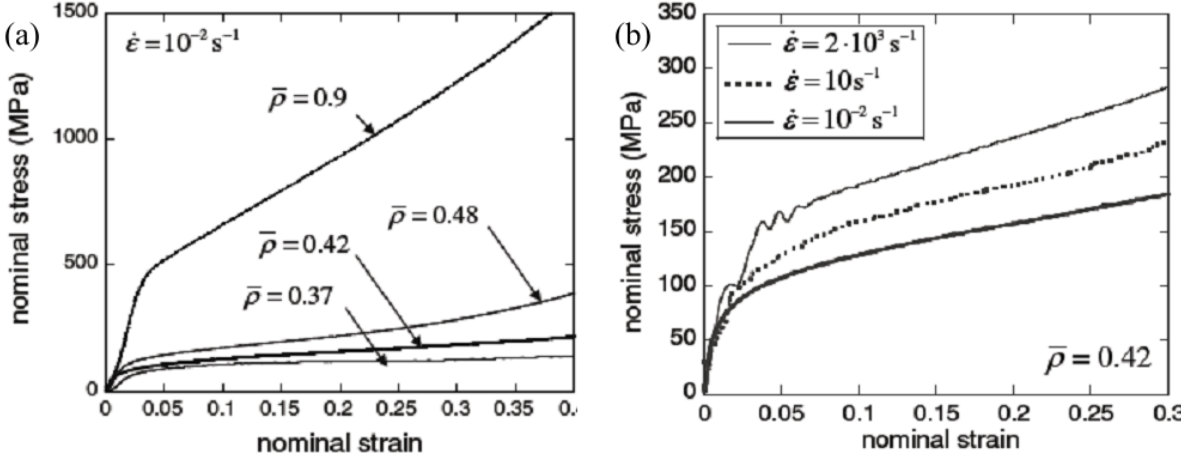
Figure 2. ( a ) Quasi-static compressive response of Ti foams of different densities; ( b ) Effect of strain rate on the compressive response of a Ti foam of relative density 0.42 